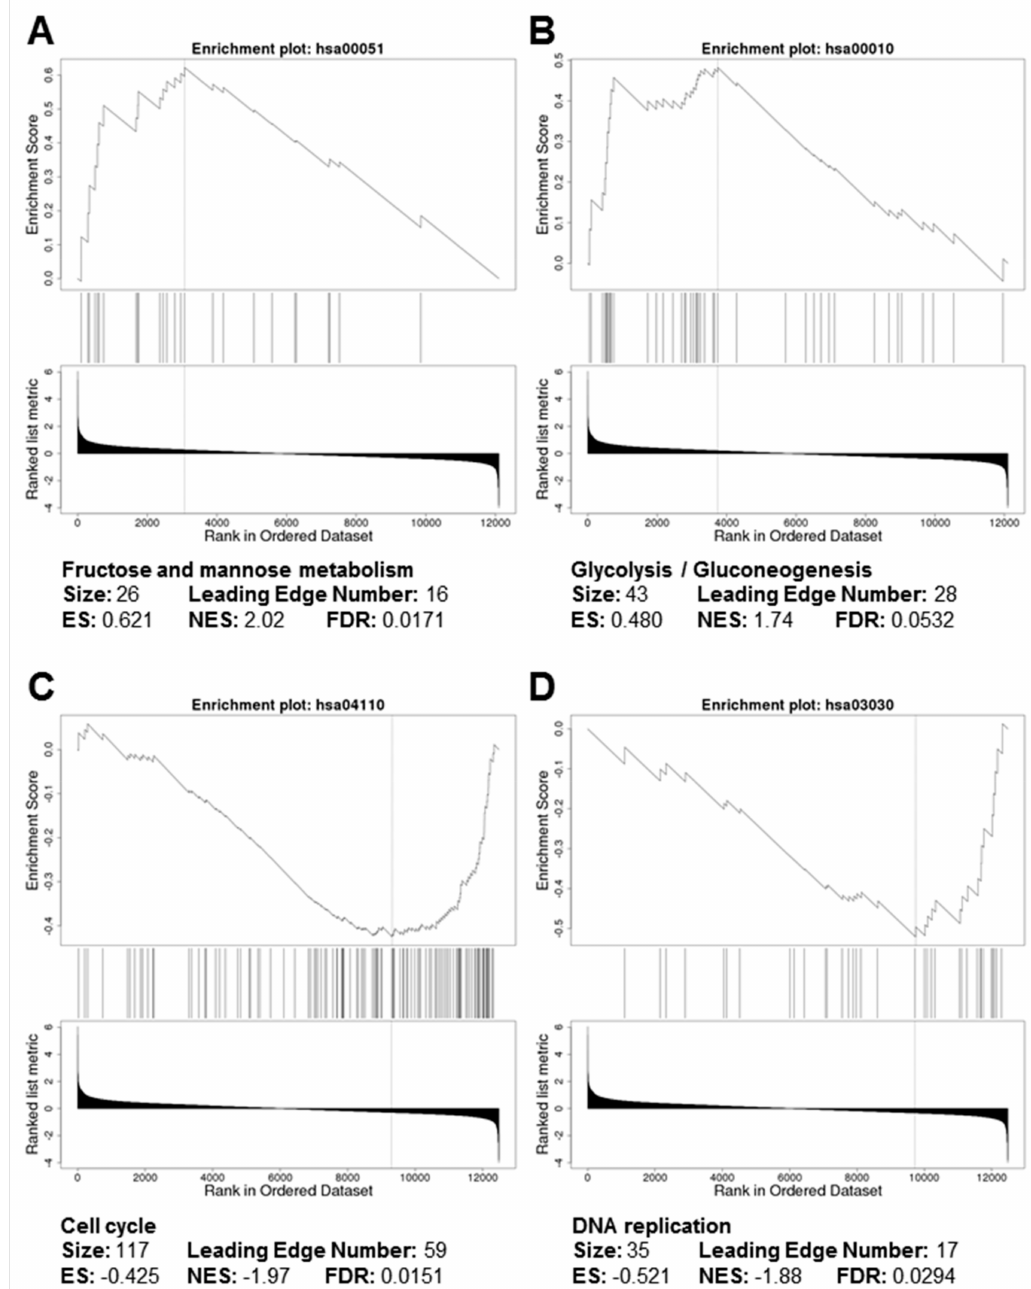
Figure 3. Gene set enrichment analysis (GSEA) plots depicting positive enrichment of ( A ) fructose and mannose metabolism and ( B ) glycolysis / gluconeogenesis and negative enrichment of ( C ) cell cycle and ( D ) DNA replication in FKBP14 -kEDS versus control